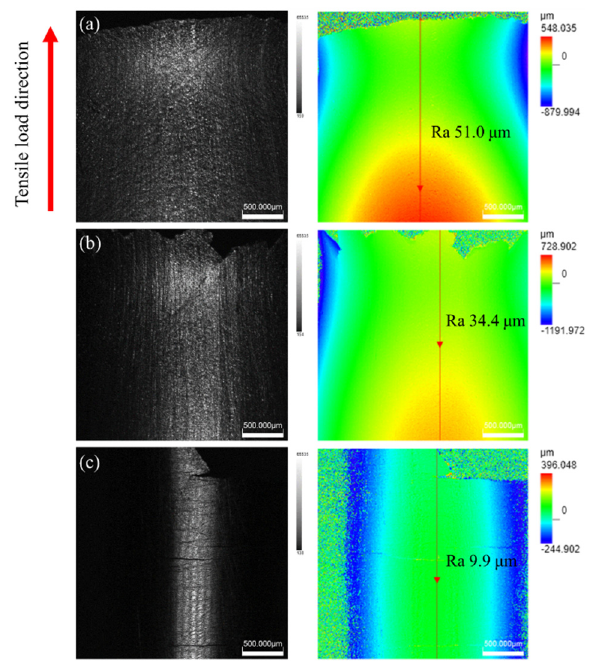
Figure 8. LSM image near the fracture site of the tensile specimen: ( a ) NPO specimen, ( b ) PO20 specimen, and ( c ) PO60 specimen.